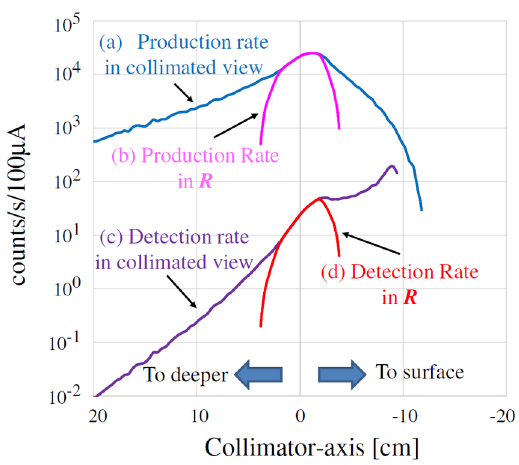
Figure 7 : Comparision with production rates and detection rates under the conditions of Cl concentration of 22 kg/m 3 , D = 5 cm, and θ = 30 degree. (a) Production rate in collimated view. (b) Production rate in R . (c) Detection rate in collimated view. (d) Detection rate in R .